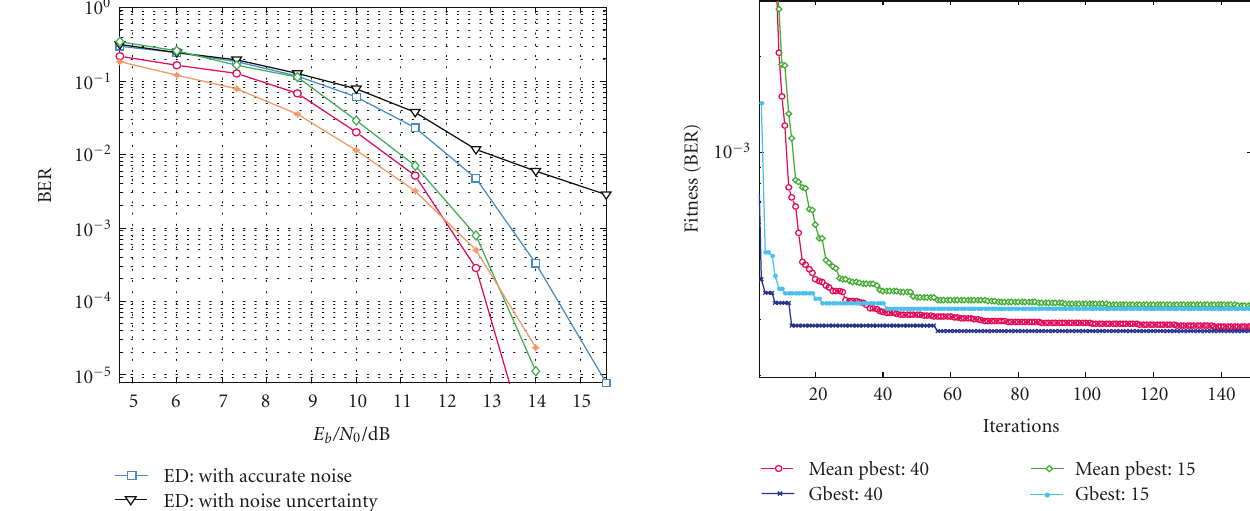
Figure 7: PSO fitness for di ff erent number of particle population. The channel SNR is